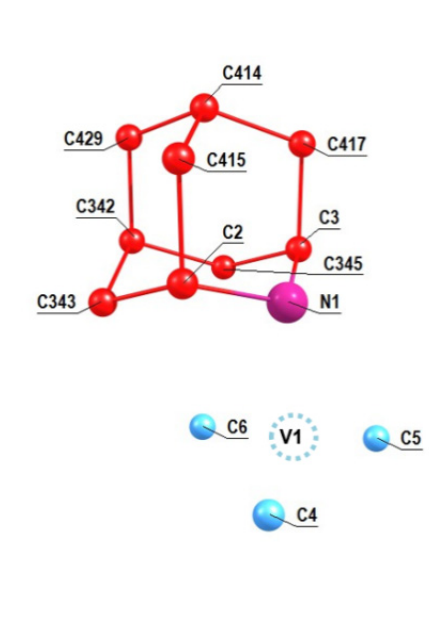
Figure 3. ( a ) Location of the 2-aza-adamantante seed in the C 510 [NV]-H 252 cluster of the work [33] at the NV1 orientation of the formed NV center and ( b ) the numeration of the carbon atoms of the seed (shown in red) in the cluster. Nearest neighbors of the vacancy V1 of the center are shown in light blue.